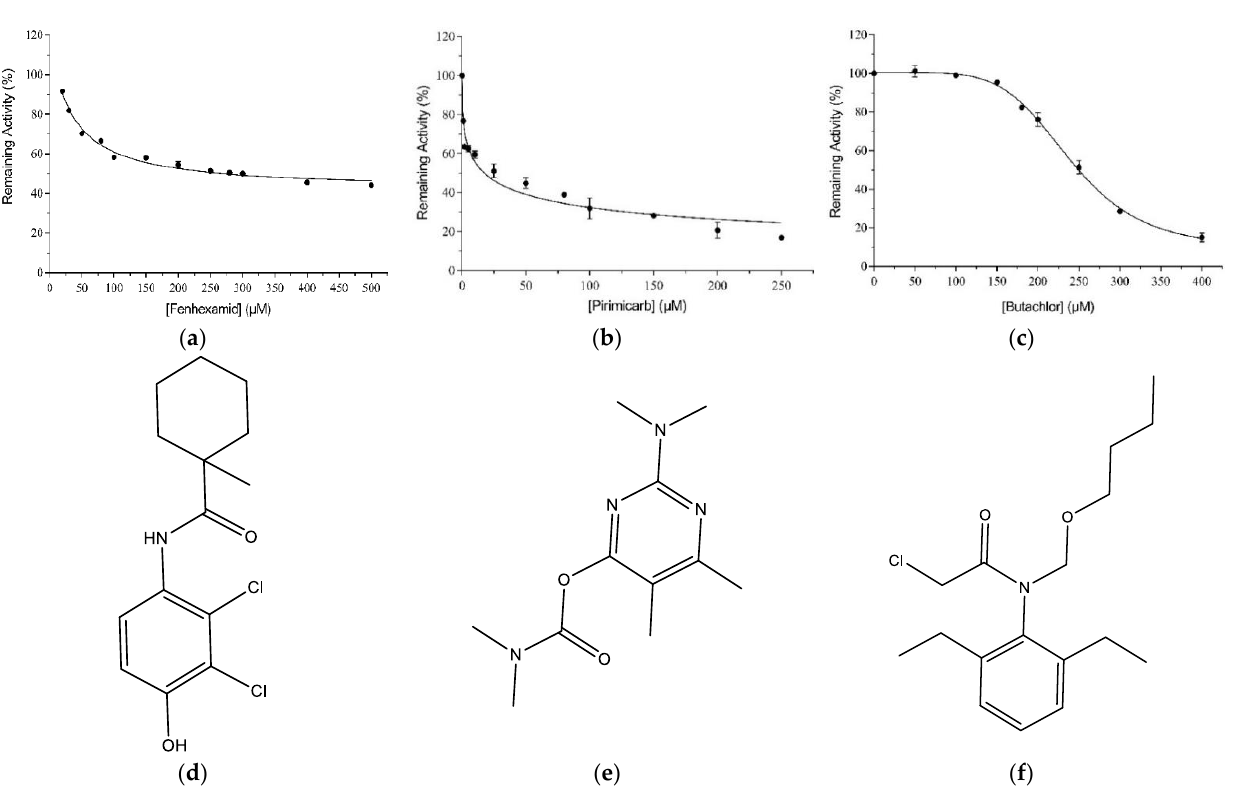
Figure 2. Concentration – response curve for fenhexamid ( a ), pirimicarb ( b ), and butachlor ( c ). IC 50 for hGSTM1-1 was determined by fitting Equation (4) to the data through non-linear curve-fitting methods. The structures of fenhexamid, pirimicarb, and butachlor are shown in ( d ), ( e ) and ( f ), re-